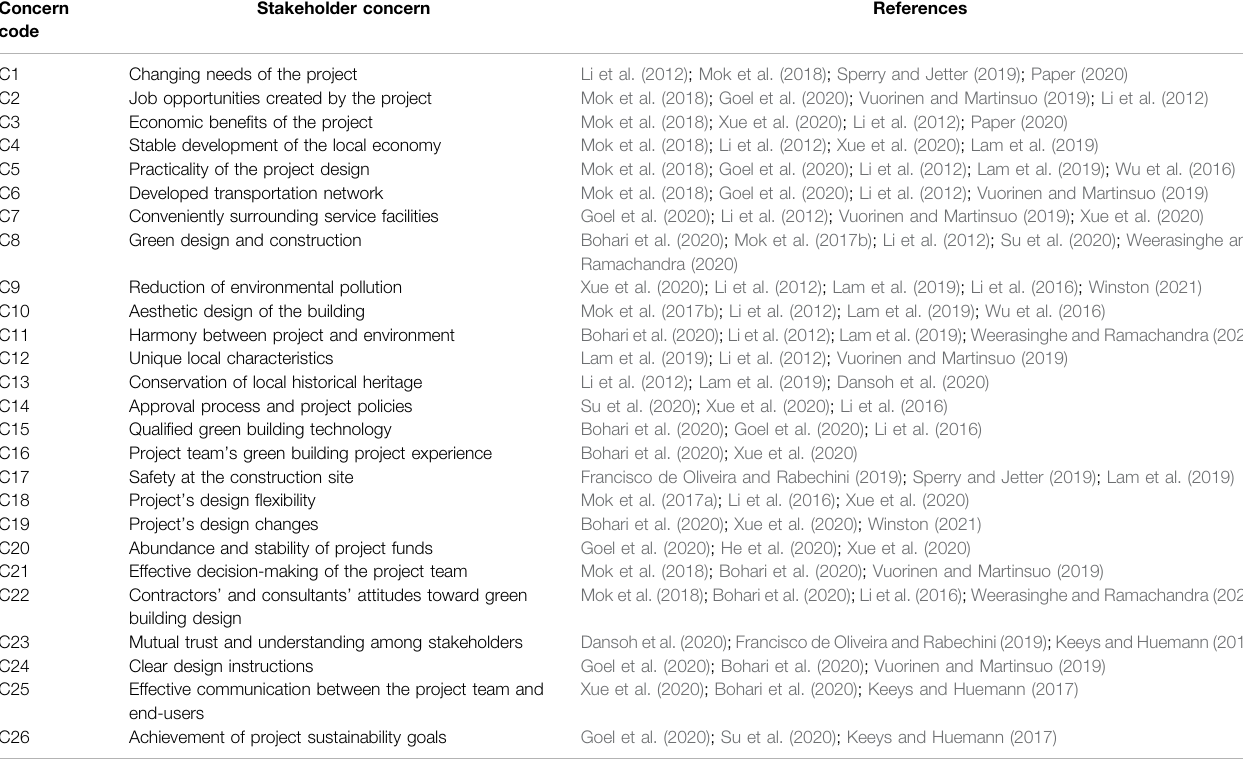
TABLE 1 | Stakeholder concerns associated with